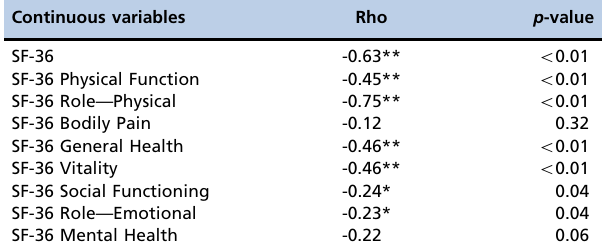
Table 3 - Correlation of the score on the Brazilian-Portuguese version of MG-QOL15 with the scores on SF-36 and its domains. Continuous variables